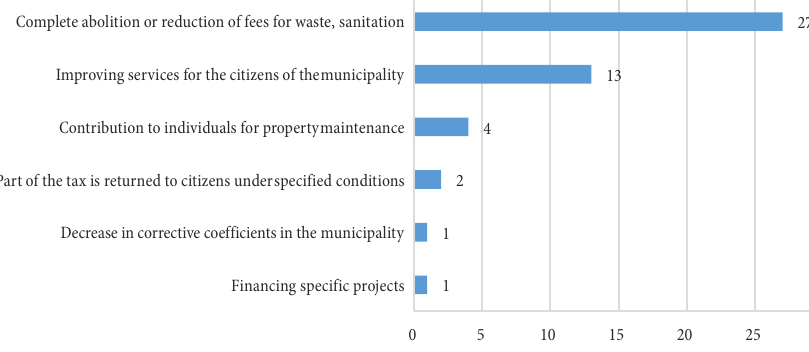
Fig. 7. Compensation for the immovable property tax increase to